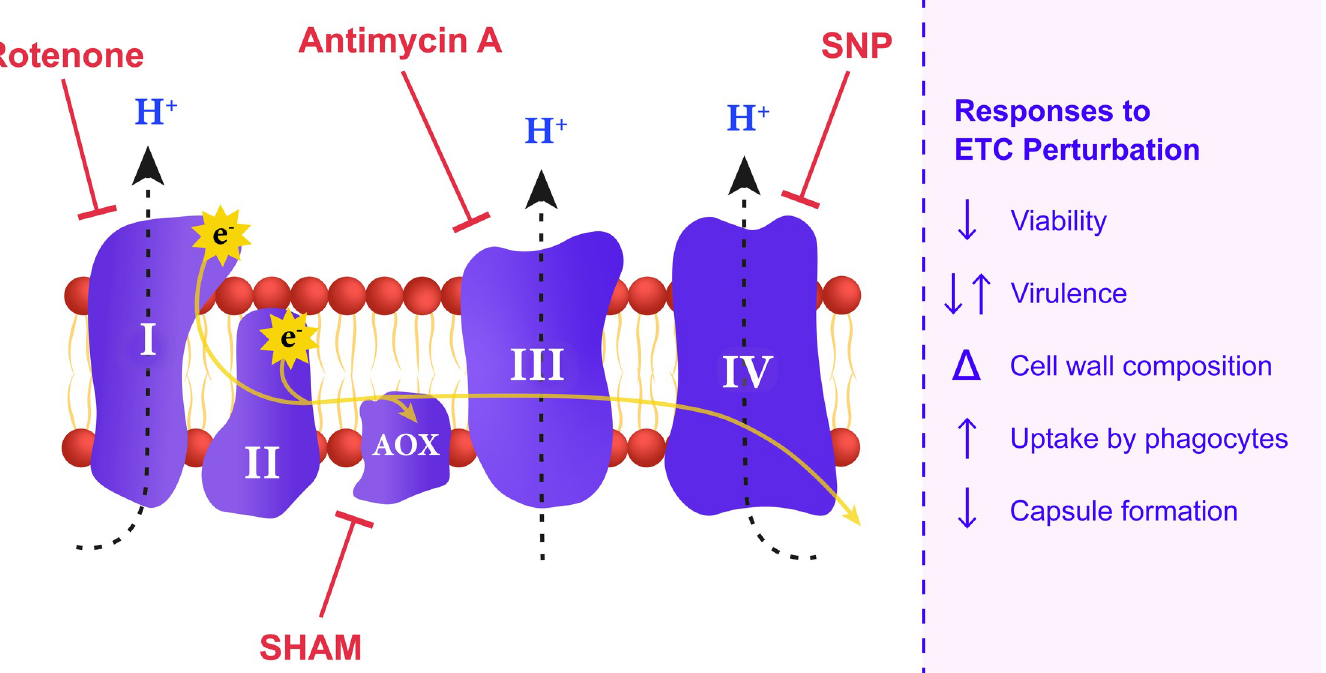
Fig 2. Inhibitors of ETC components provoke a variety of responses in fungal pathogens. A schematic illustrating the respiratory chain protein complexes in the inner mitochondrial membrane is shown along with the inhibitors that target specific complexes, as highlighted in the text. Selected examples of the key phenotypic responses to the inhibitors are indicated on the right. Note that capsule formation is specific to C . neoformans . ETC, electron transport chain; SHAM, salicylhydroxamic acid; SNP, sodium nitroprusside.